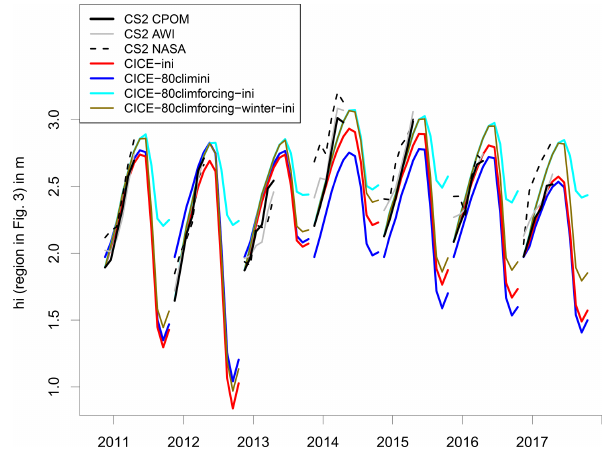
Figure 10. Impact of climatological initial conditions (climini), cli- matological forcing (climforcing), and climatological forcing dur- ing winter only (November to April, climforcing-winter). All CICE simulations from CICE-ini best. Mean effective sea ice thickness over the region is shown in Fig. 3. CS2 as in Fig. 7. The climatology is calculated over the period 2011 to 2017 for air temperature, hu- midity, downward longwave and shortwave radiation, rainfall, and snowfall. The real wind forcing is applied in all simulations.